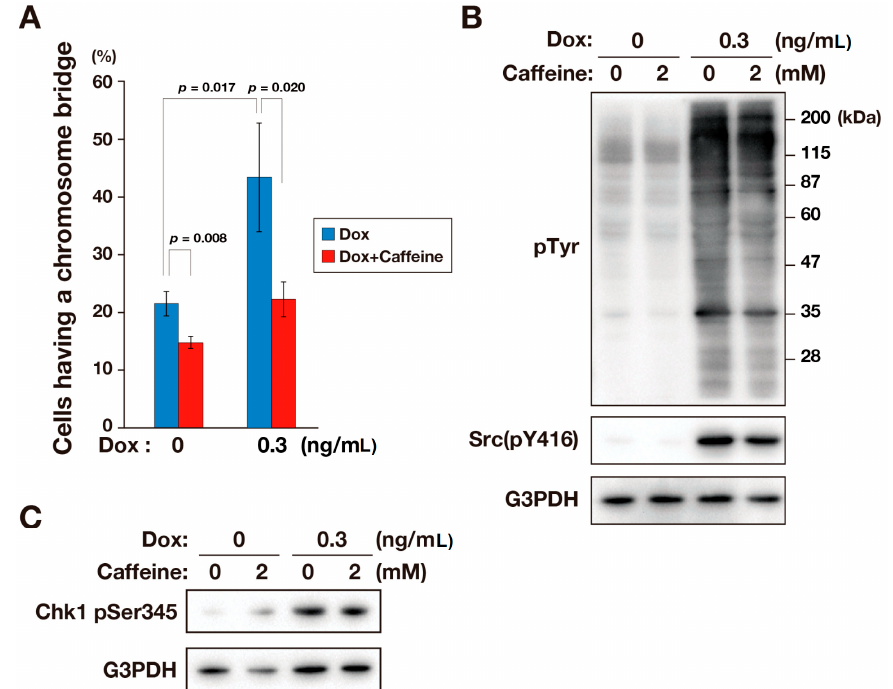
Figure 4. Caffeine inhibits the formation of chromosome bridges. HCT116/v-Src cells were cultured with Dox for three days at the indicated concentrations. The cells were treated with or without 2 mM caffeine for one day before fixation or lysate preparation. ( A ) The percentage of anaphase and telophase cells with a chromosome bridge were plotted. The results represent the mean ± S.D. from three independent experiments. p values were calculated using a two-tailed Student’s t -test; ( B ) Whole cell lysates were subjected to a Western blot analysis. Blots were probed with anti-phosphotyrosine (pTyr), anti-Src (pY416), and anti-G3PDH (loading control) antibodies; ( C ) Whole cell lysates were subjected to a Western blot analysis. Blots were probed with anti-Chk1 pSer345 and anti-G3PDH (loading control) antibodies. In B and C , a representative result of two independent experiments is shown.